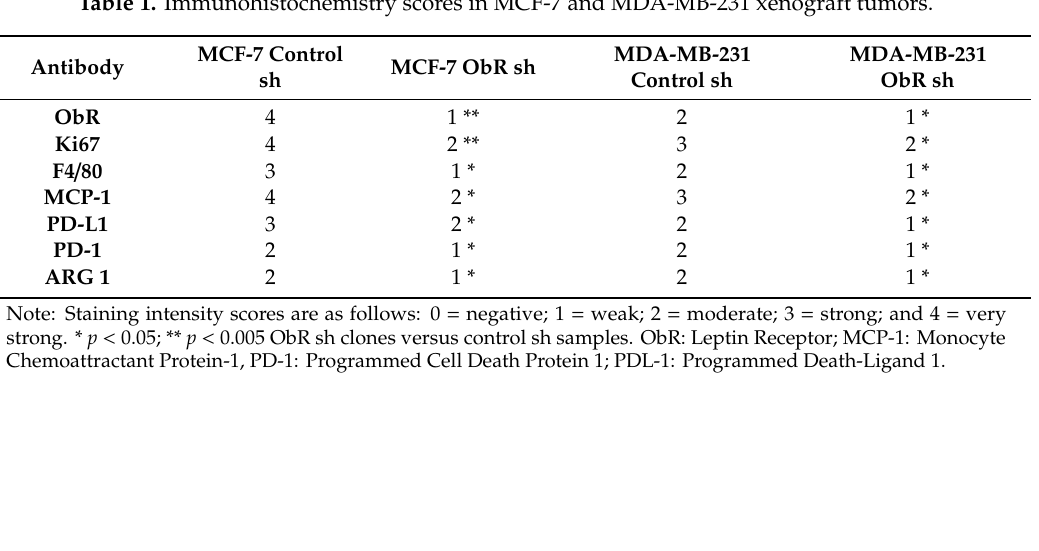
Figure 2. E ff ects of ObR knockdown on MCF-7 and MDA-MB-231 breast cancer cell phenotype. ( A , F ) Growth kinetics and ( B , G ) soft agar growth assays of Control sh and ObR sh MCF-7 and MDA-MB-231 breast cancer cells. ( C , H ) Wound healing, ( D , I ) Boyden chamber transmigration and ( E , L ) invasion assays in Control sh and ObR sh MCF-7 and MDA-MB-231 breast cancer cells. Pictures are representative of three independent experiments. The values represent the mean ± SD of three di ff erent experiments, each performed in triplicate. * p < 0.05, ** p < 0.005. Table 1. Immunohistochemistry scores in MCF-7 and MDA-MB-231 xenograft